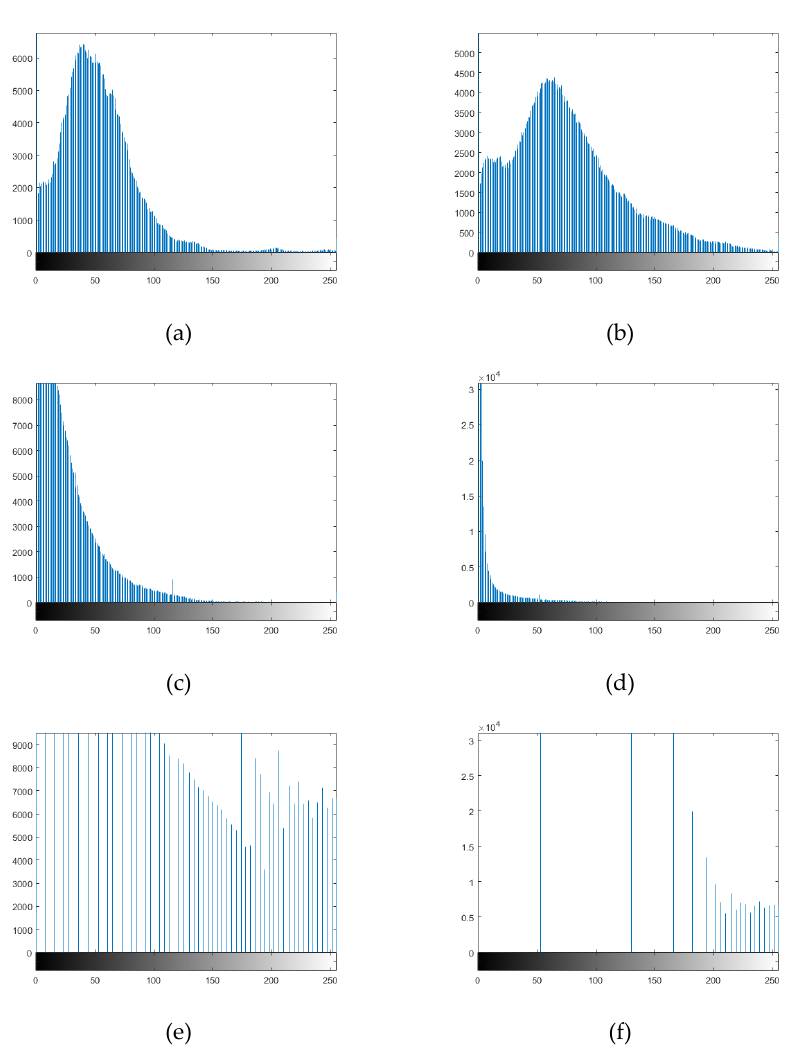
Figure 12. The histograms of 6 images. ( a ) Cred_V after linear stretching; ( b ) Cred_S after linear stretching; ( c ) DISV after linear stretching (LSDISV); ( d ) DISS after linear stretching (LSDISS); ( e ) LSDISV after histogram equation; ( f ) LSDISS after histogram